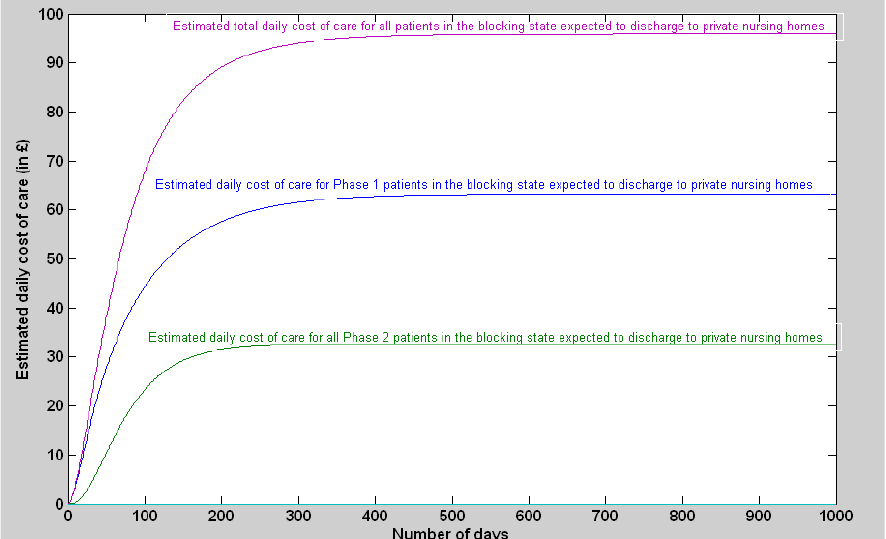
Figure 18. The estimated daily cost of care for patients in the blocking state of each phase expected to be discharged to private nursing homes (for mean discharge delay τ = 10 days).